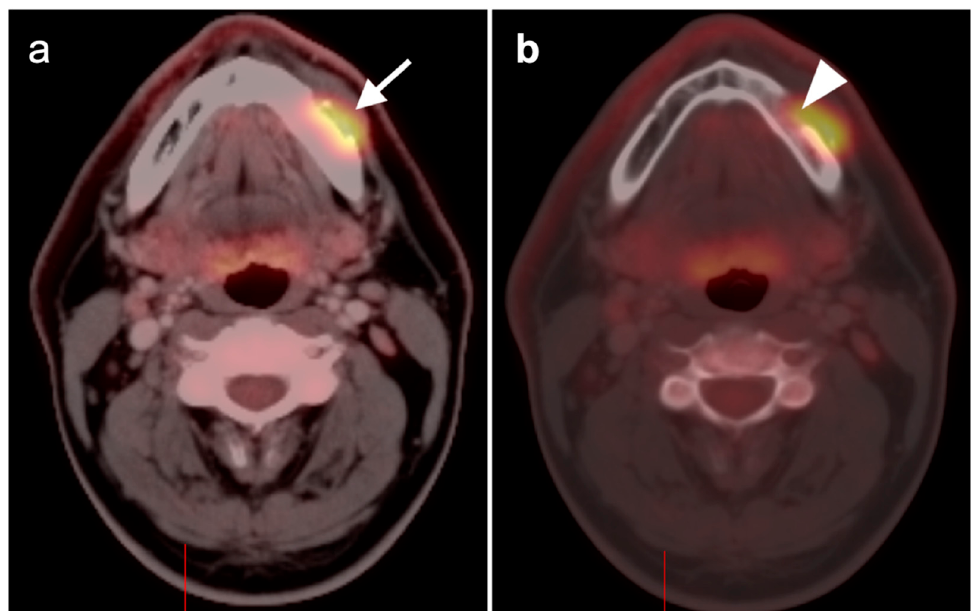
Figure 11. Squamous cell carcinoma of the oral tongue on FDG PET ‐ CT. ( a ) Hypermetabolic tumor involves the left oral tongue (white arrowhead). ( a , b ) There is spread to the left floor of mouth mus ‐ culature shown on both axial ( b ) and sagittal ( c ) imaging (white arrowheads). ( b ) There is also a left level 2A hypermetabolic cervical lymph node consistent with nodal spread of disease.